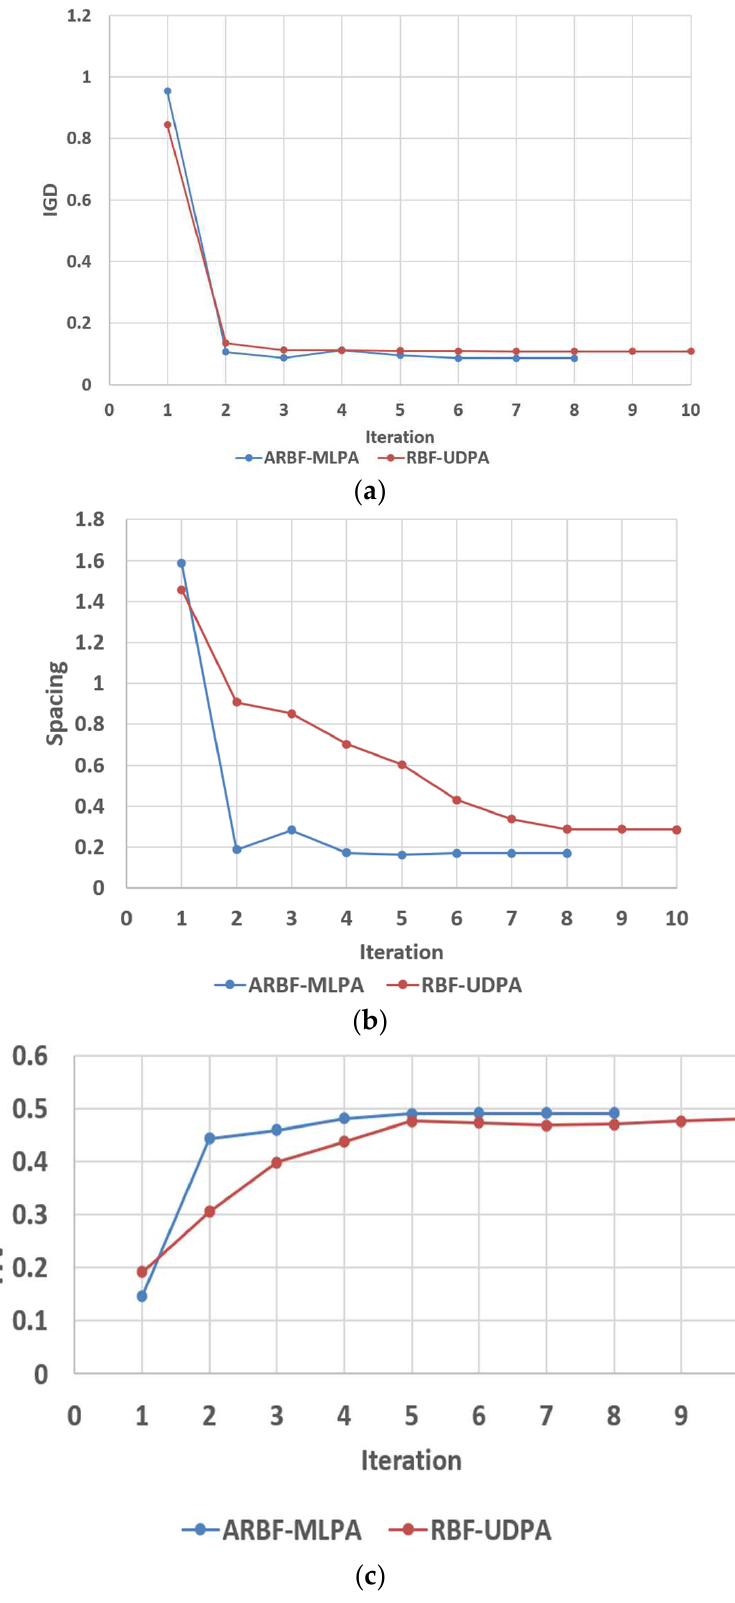
Figure 5. ( a ) IGD under function ZDT2. ( b ) Spacing under function ZDT2. ( c ) HV under function ZDT2.